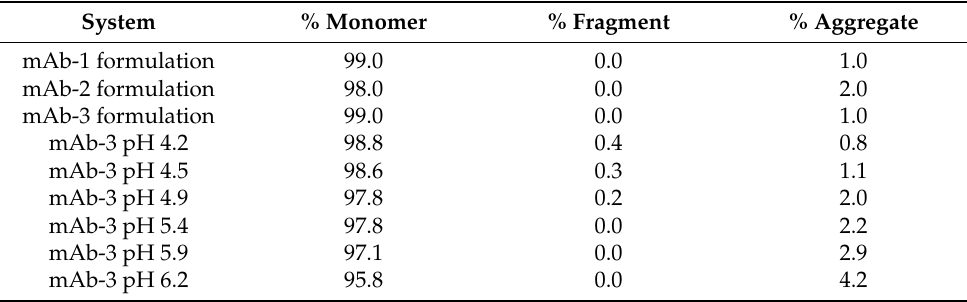
Table 2. Size exclusion chromatography (SEC) data on monoclonal antibodies.